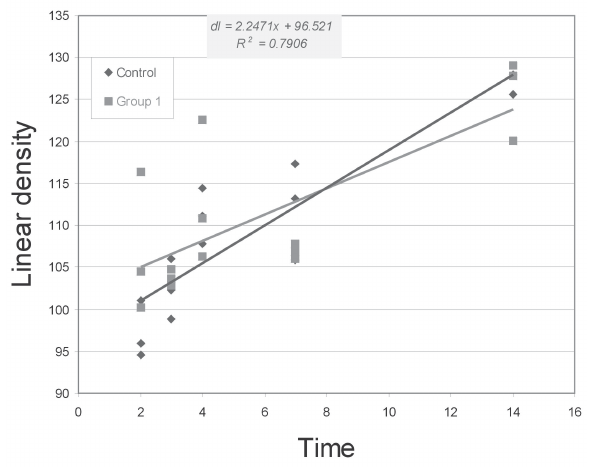
FIGURE 3 - Study of the dispersion of Linear Density data as a result of time with interpolation of data by means of linear regression